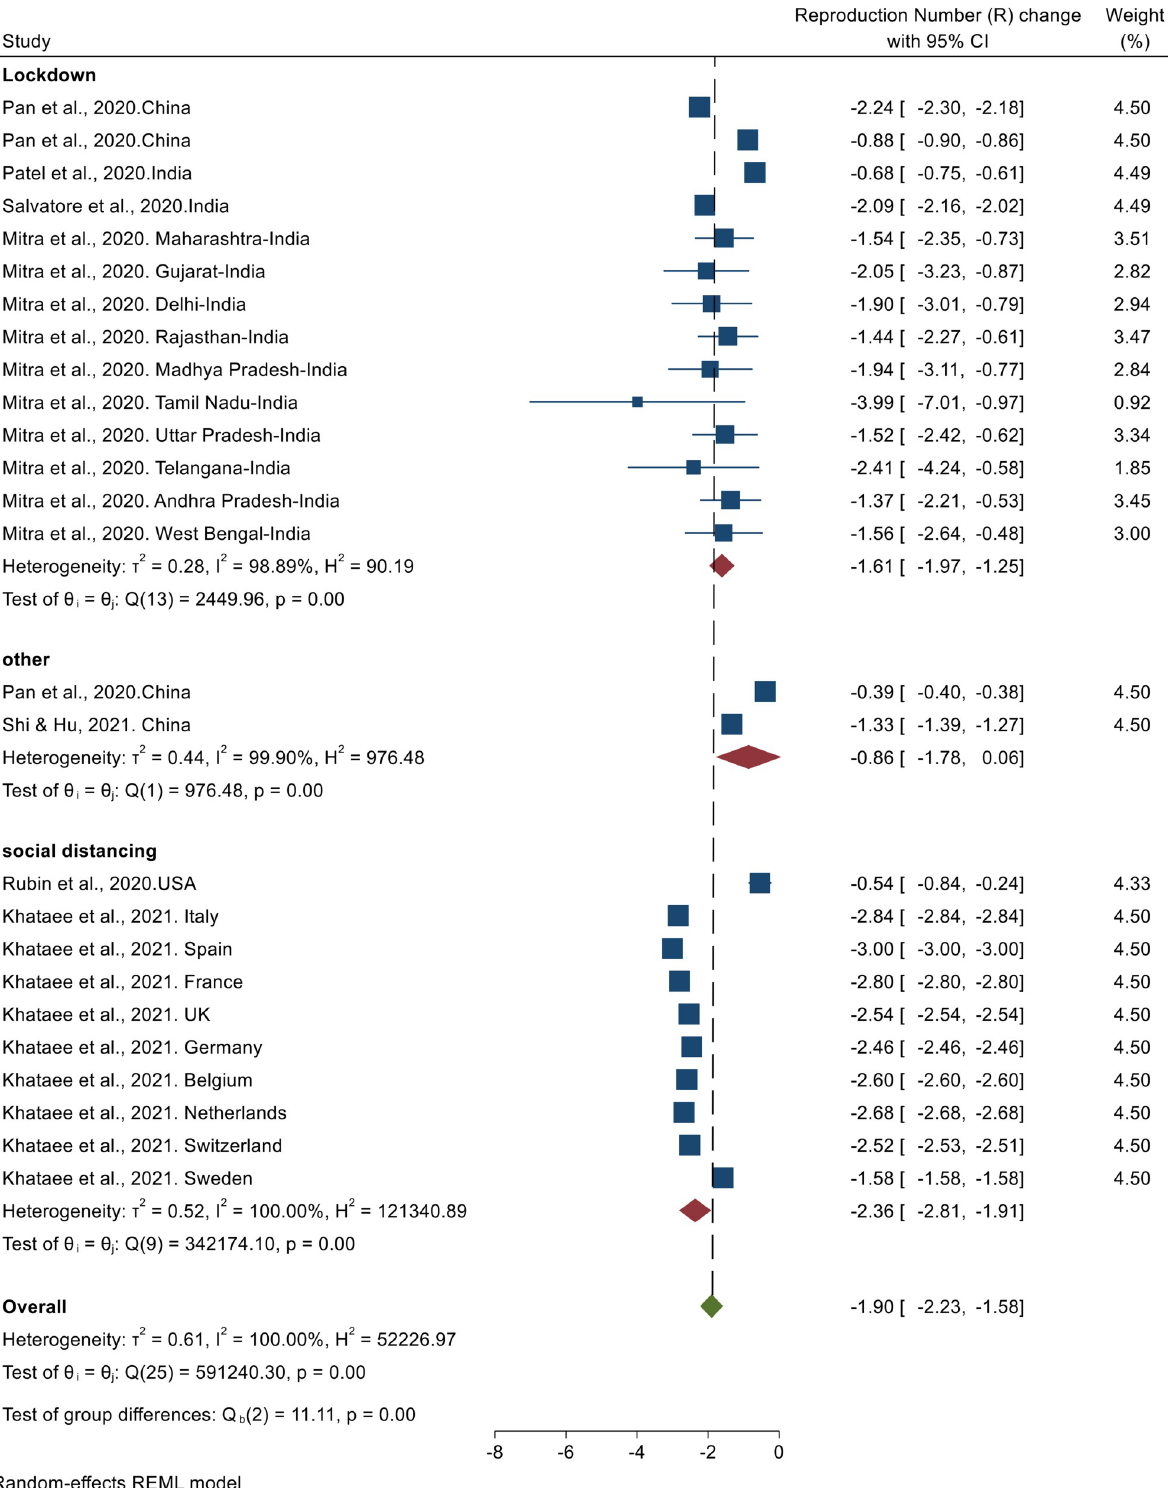
Fig 4. Results of the meta-analysis of the effects of NPHIs on changes in the Covid-19 reproduction number in the communities based on a random effect model.